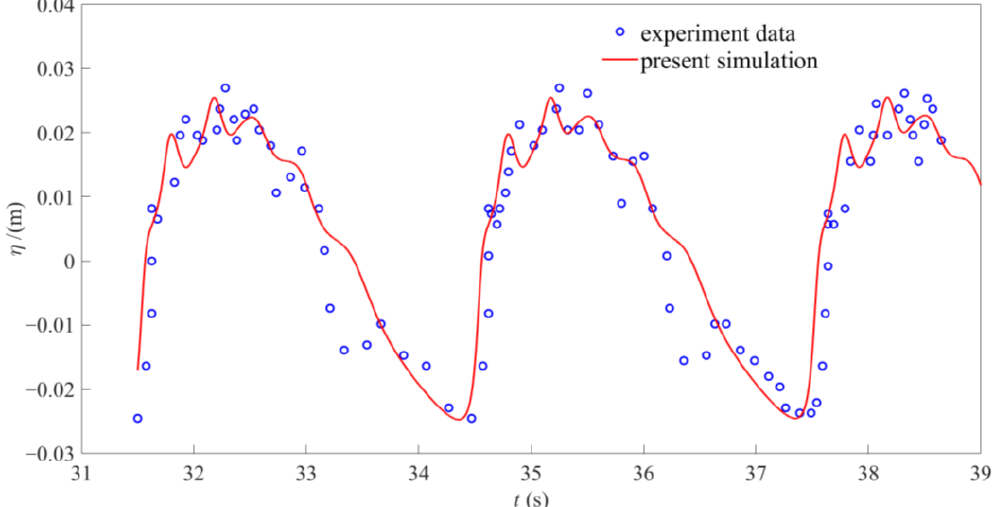
Figure 5. Comparison of the time history of free surface elevation at y = 0.05 between the results of the present simulation and experimental data of Bouscasse [36].